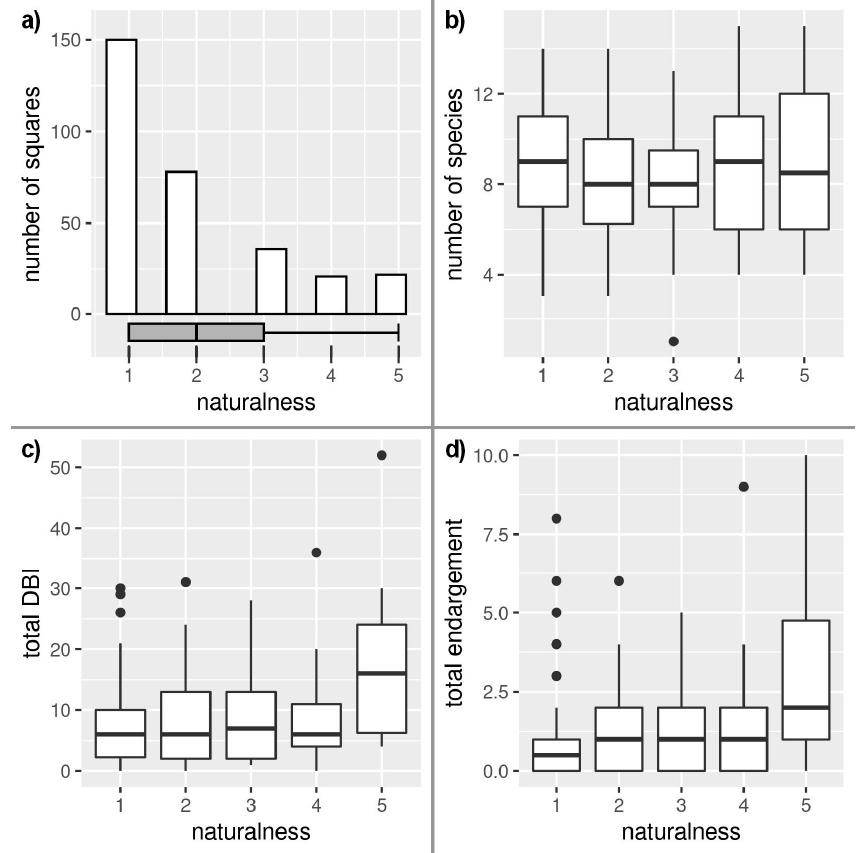
Figure 3. Dependence of naturalness on: ( a ) number of squares in a grid, ( b ) species richness, ( c ) Dragonfly biotic index (DBI), and ( d ) endangerment.